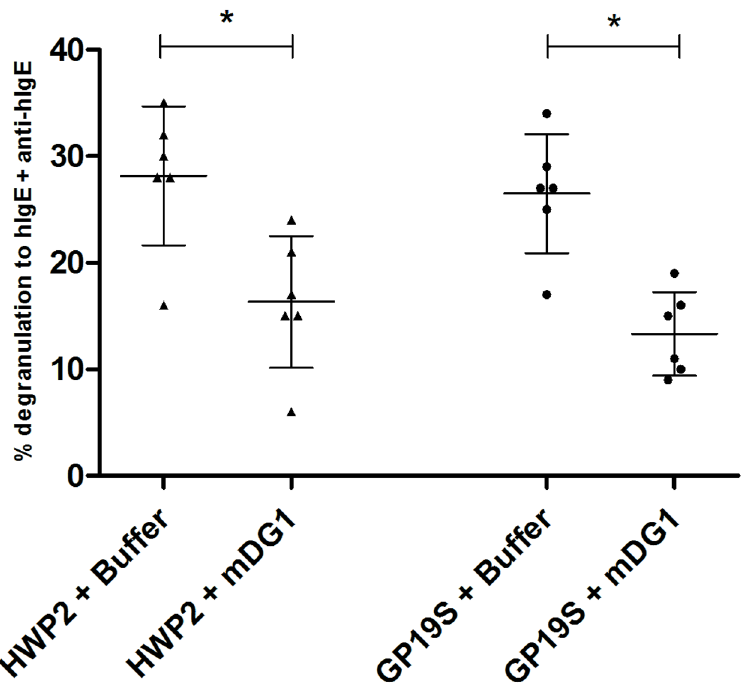
Fig 3. Inhibition of HWPs-induced-degranulation of RBL-SX38 cells by mAb mDG1. Human Fc ε RI- expressingRBL cells were passivelysensitized with 6 sera (#30, 285, 299, 352, 1414, 1649) and subsequently cross-linkedwith anti-human IgE antibodies, HWP2 (100 ng/mL) or GP19S (100 ng/mL), pre- incubatedfor 1 h with purifiedmouse monoclonal antibody mDG1 (20 μ g/mL). The results are expressed as percentage of degranulation comparedto anti-human IgE-induceddegranulation. HWP, hydrolyzedwheat protein. GP19S, Glupearl19S ® . Symbols represent means of triplicates. Horizontalbars representmean, and error bars represent ± SD. Data were analyzedwith a Wilcoxon matched-pairs signedrank test for HWP2 or GP19S ( * : p (cid:20) 0.05).